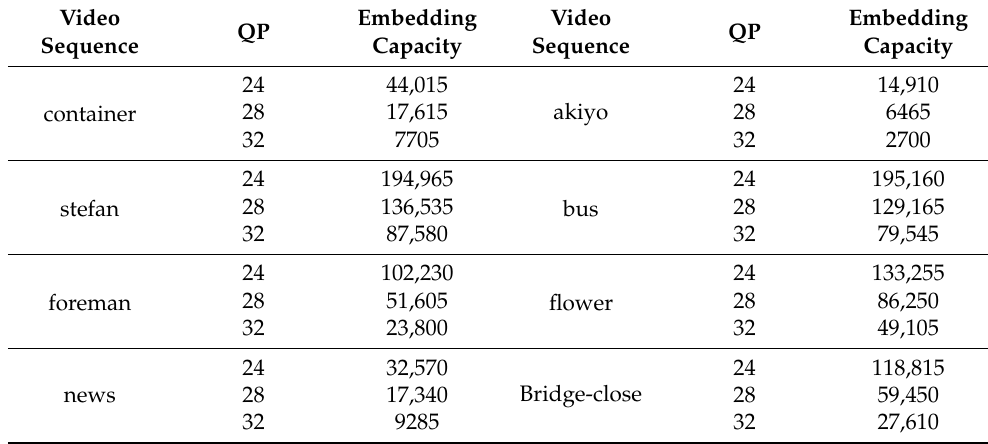
Table 5. The max embedding capacity of each video sequence.